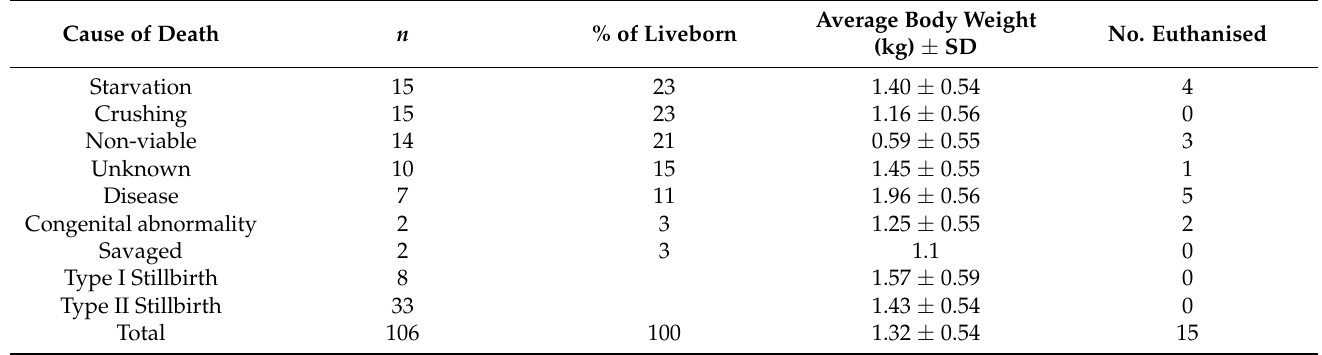
Table 2. Overview of the number and percentage of piglets that died due to different causes as determined by